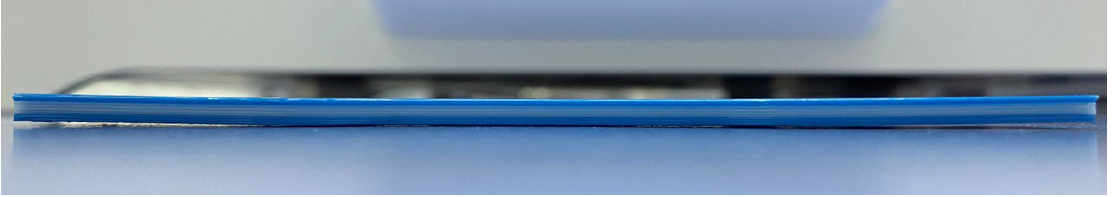
Figure 14. Printed multi-material sandwich specimen.